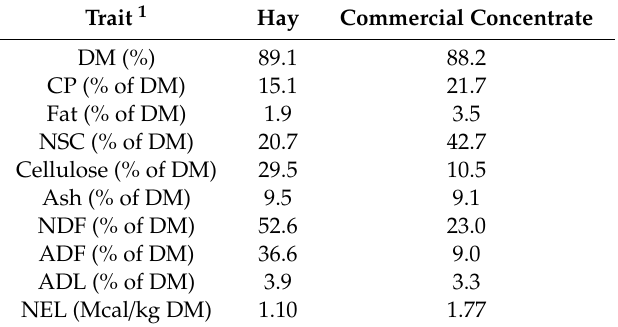
Table 1. Chemical composition and energy content of the hay and the concentrate administered to the goats during the